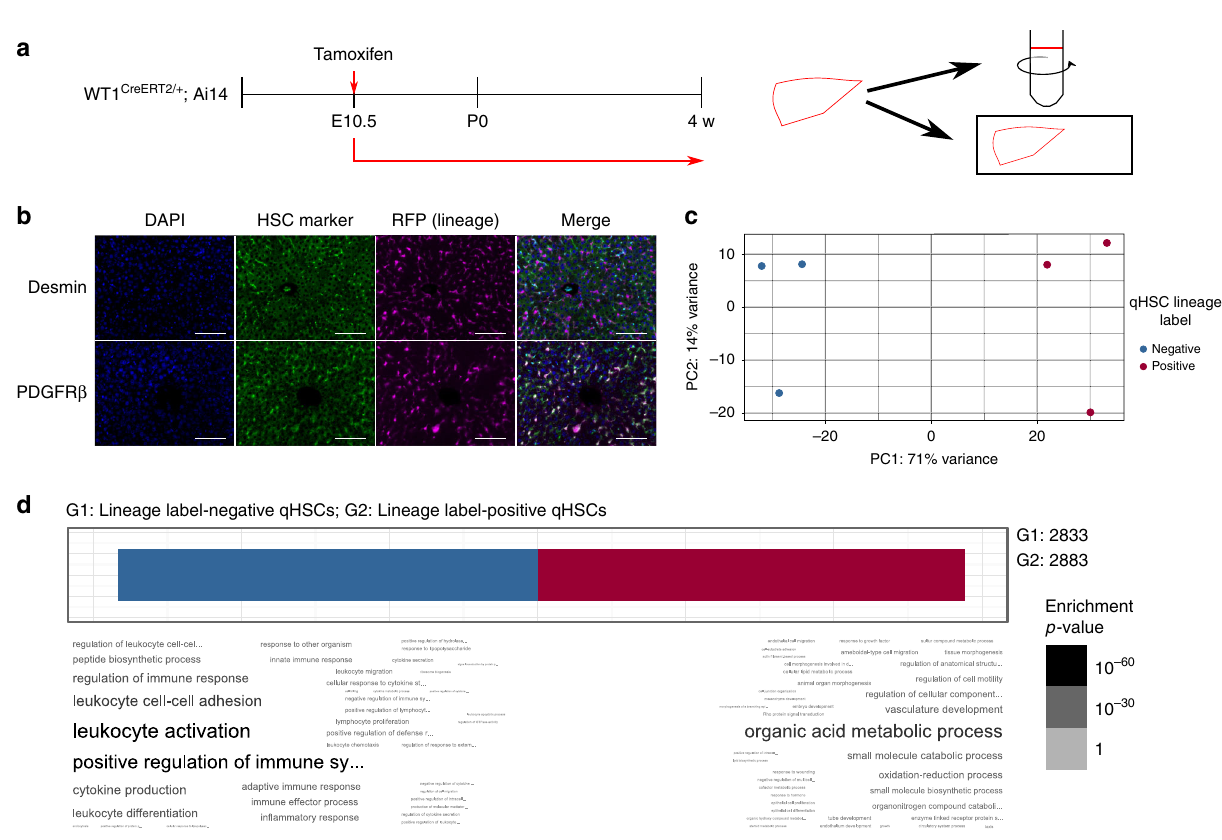
Fig. 1 Functionally distinct subpopulations of qHSCs derive from alternative embryological origins. a Lineage labelling of hepatic mesothelial cells and their progeny was induced at E10.5 in WT1 CreERT2/ + ;Ai14 animals, and qHSCs isolated or livers examined in adulthood. b Adult WT1 CreERT2/ + ;Ai14 livers, labelled at E10.5, were stained for lineage label (RFP) and qHSC markers (desmin and PDGFR β ); 68.4 ± 3.46% qHSCs were lineage label positive (mean ± s.e.m., n = 3, scale bars 100 μ m). c The presence of the lineage label was the major component describing variation in differentially expressed genes between lineage-labelled and unlabelled populations of qHSCs isolated from adult WT1 CreERT2/ + ;Ai14 livers ( n = 3), labelled at E10.5. d GO term analysis of differentially expressed genes between lineage-labelled and unlabelled qHSCs showed distinct functional pro fi les depending on